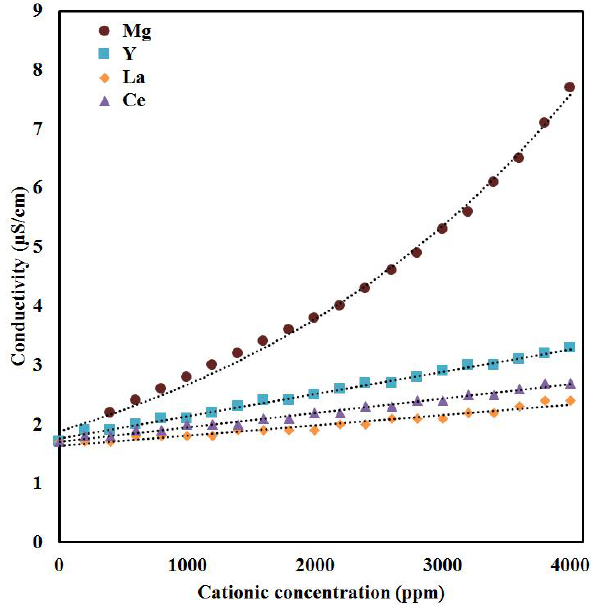
Fig. 1. Conductivity changes of suspension by separated cation concentration. Suspension made by 100mL ethanol, 400 ppm Iodine and 20 g alumina nano powder. Lanthanum concentration (♦), Yttrium concentration (■), Cerium concentration (▲) and Magnesium concentration (●).